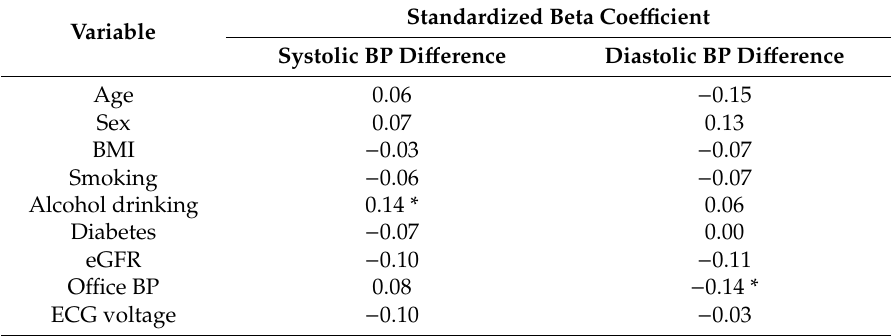
Table 3. Determinants of the di ff erences between the home and ambulatory blood pressure, as determined by the linear regression